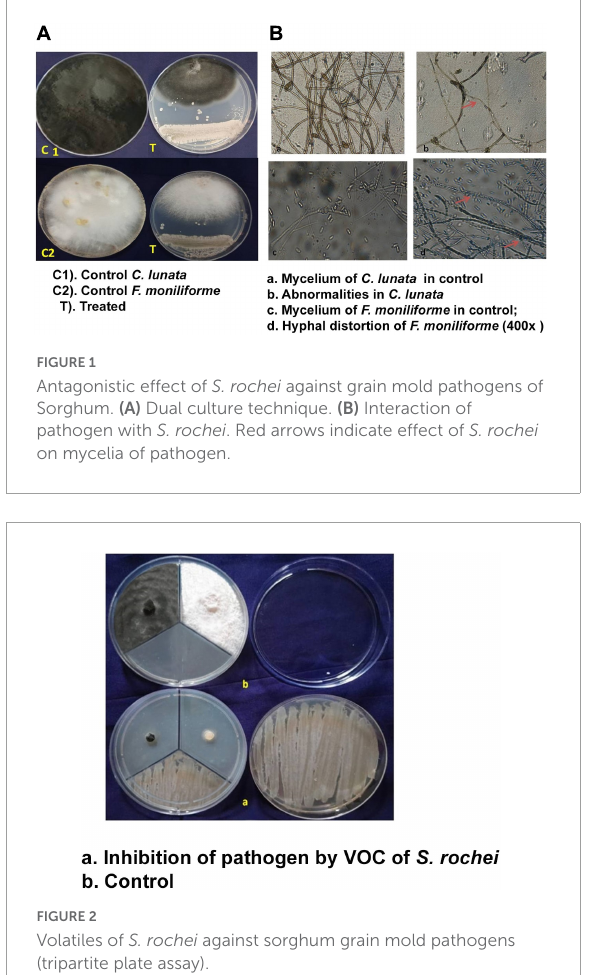
FIGURE2 Volatiles of S. rochei against sorghum grain mold pathogens (tripartite plate assay).